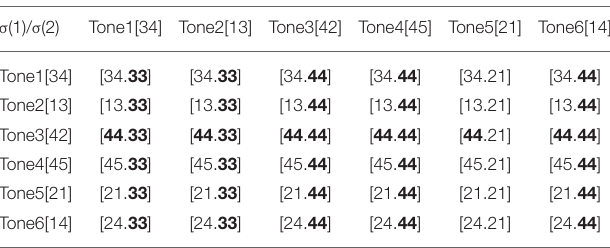
The dot “.” stands for syllable break, and numbers in bold indicate sandhi forms.